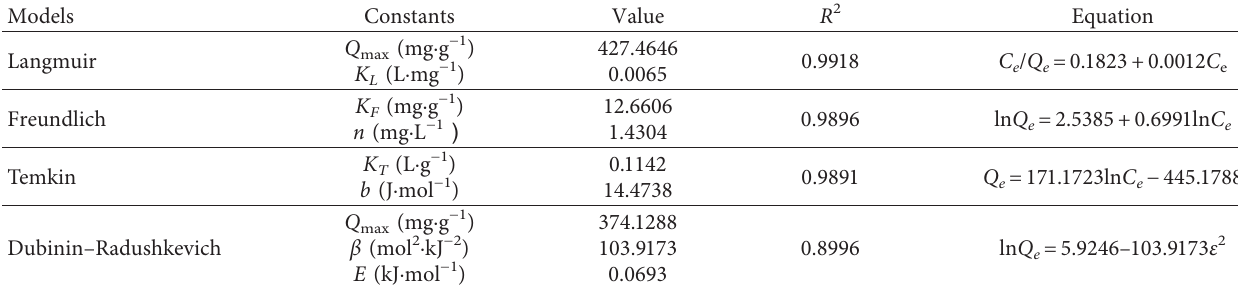
Table 4: Adsorption isotherm model parameters for adsorption of Cr(VI) on S2.